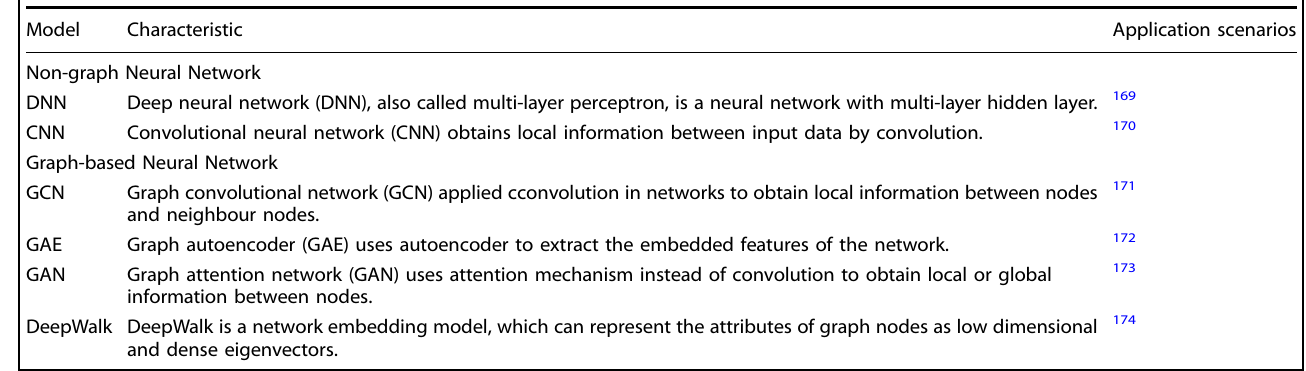
Table 4. Commonly used neural networks in ML-based biology analysis Model